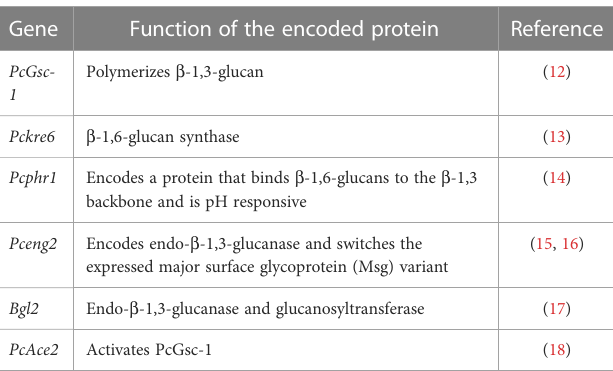
TABLE 1 Genes encode enzymes located within the cell membrane that participate in the formation of the glucose backbone in the Pneumocystis cell